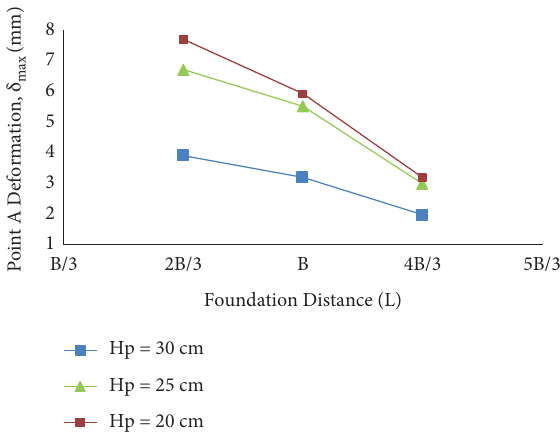
Figure 10: Changes of δ max vs. L in the cases of H